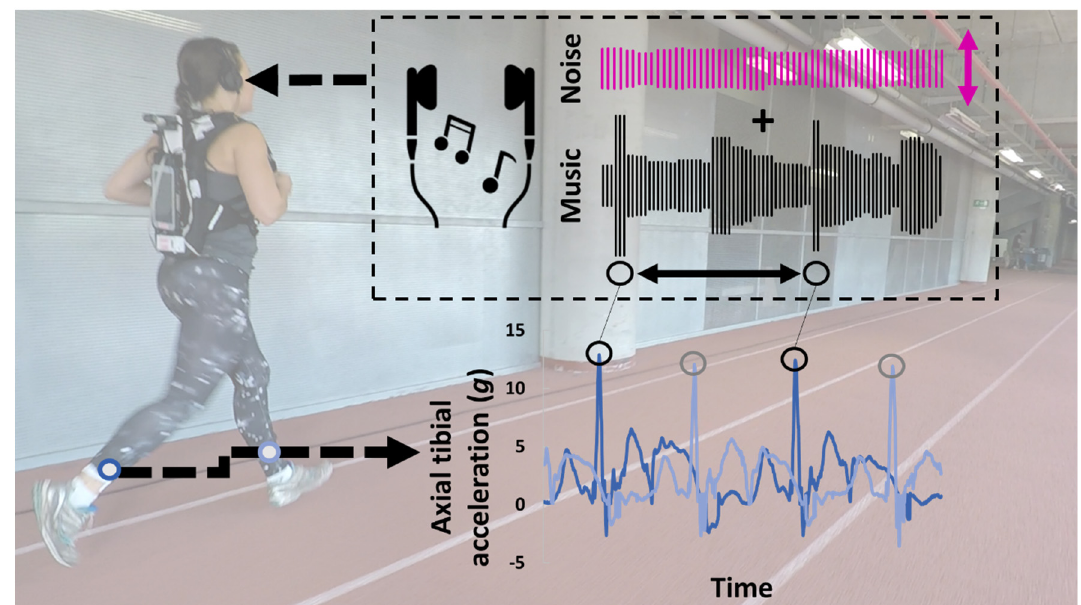
Figure 3. A subject running indoors on an athletic track (287 m / lap) at the instructed speed of ~3.2 m · s − 1 . Real-time auditory biofeedback in response to the axial peak tibial acceleration was provided by a wearable interactive system to the runner with high axial peak tibial acceleration. The sensor processing involved real-time peak detection. The music processing comprised tempo synchronization of the music combined with peak-based noise added to the music playing.